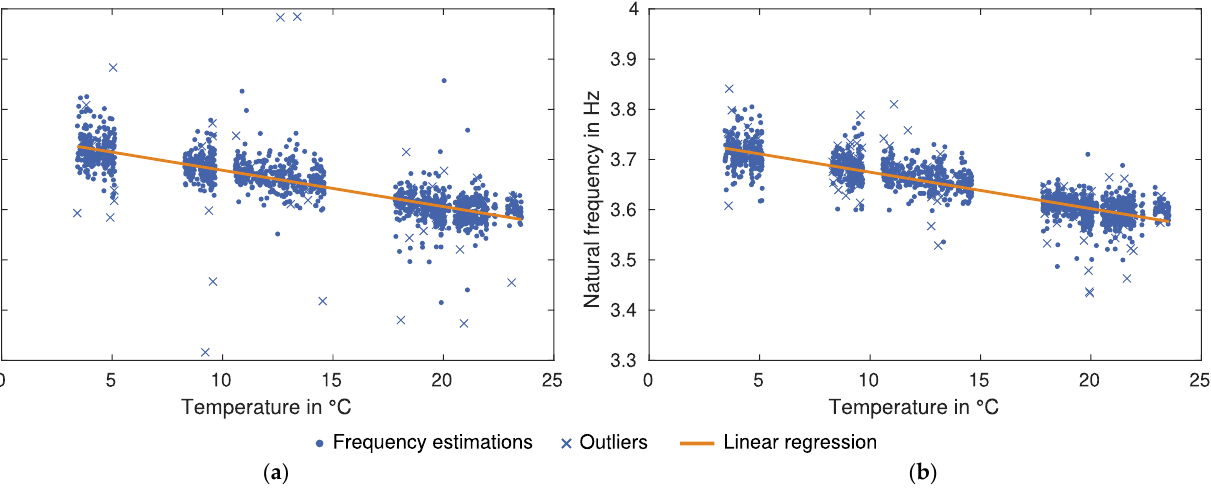
Figure 5. Natural frequencies estimated by the least squares approach ( a ) from GBR measurements with the best approach and ( b ) from strain measurements with the mean approach